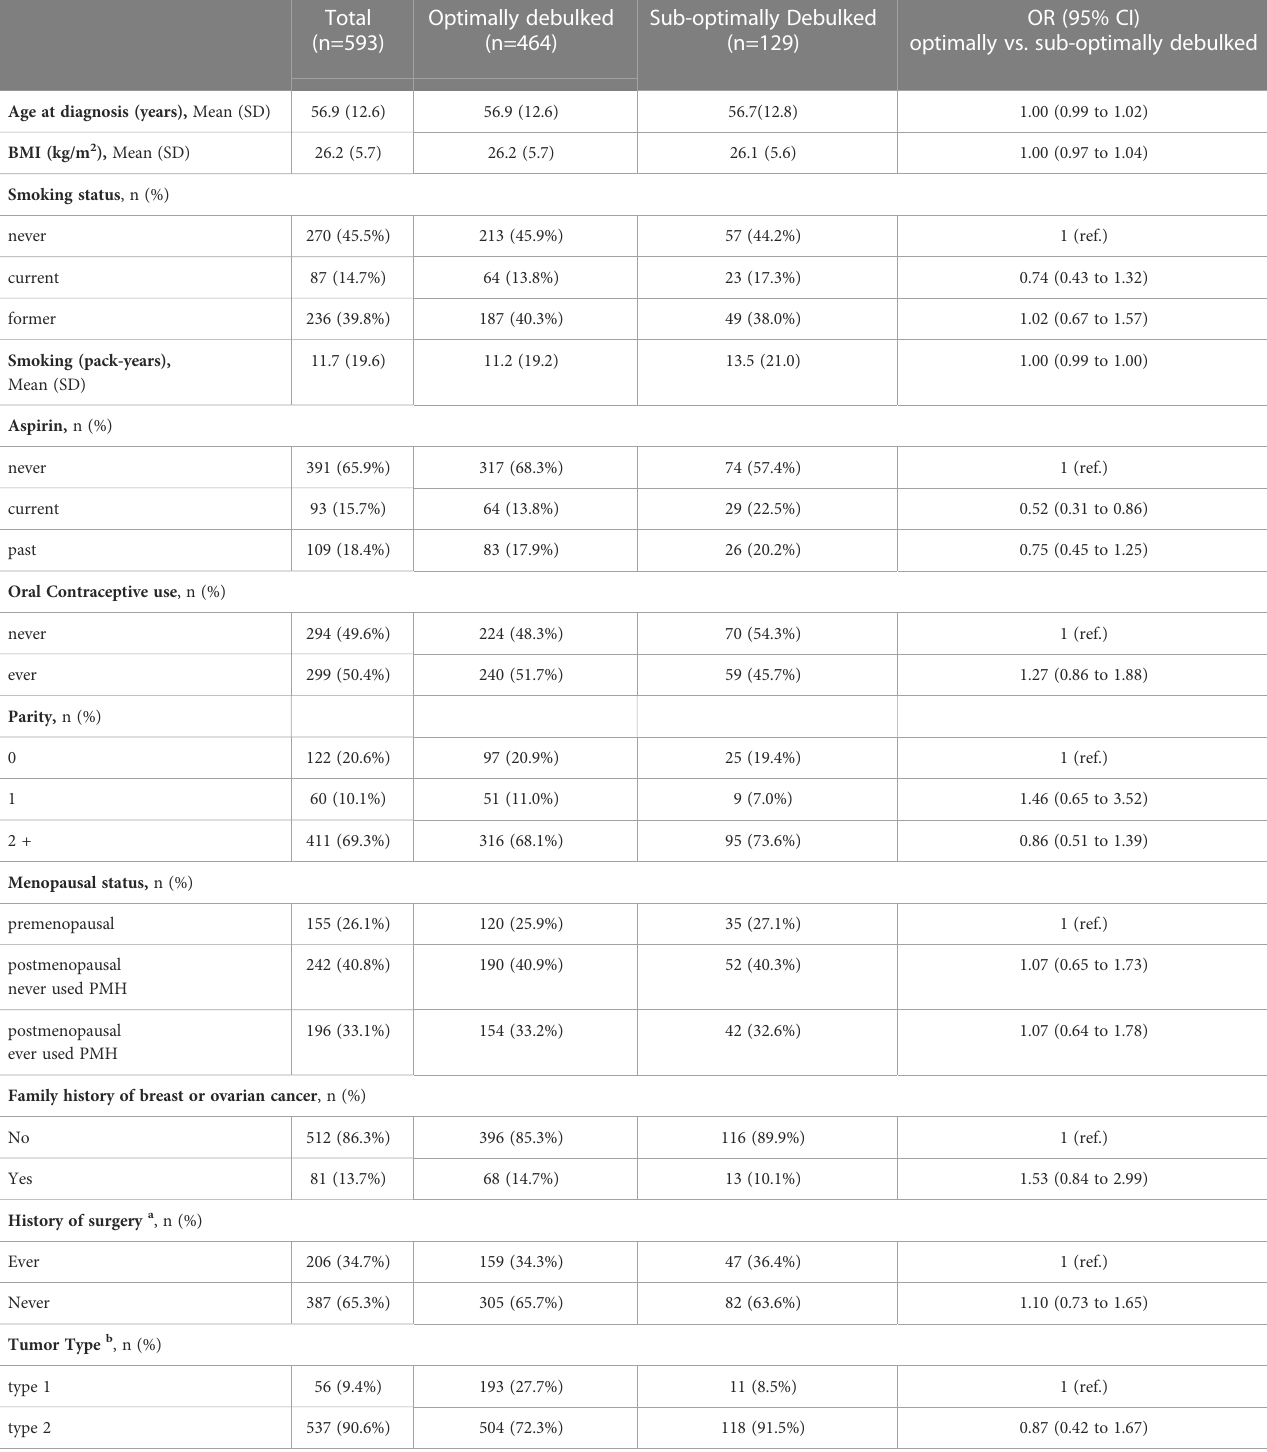
TABLE 1 Association between demographic/clinical characteristics and debulking status (1=optimally debulked, 0 = sub-optimally debulked) among advanced stage invasive epithelial ovarian cancer cases in